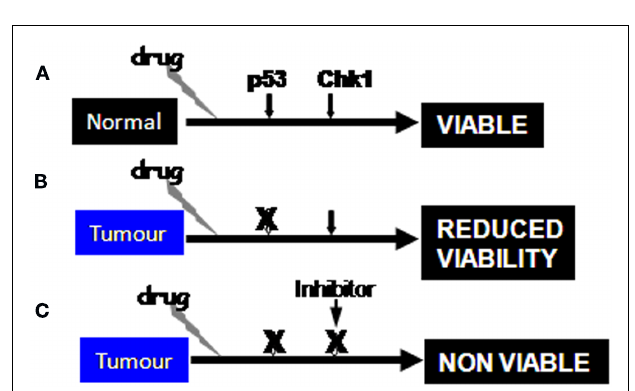
FIGURE 4 |Administration of genotoxic drugs can be readily responded to by p53-dependent mechanisms in normal tissues (A), whereas loss of p53 function will reduce cell viability and result in cells becoming reliant on the Chk1 dependent G2 phase checkpoint (B). Inhibition of Chk1 in combination with drug treatment results in loss of viability (C) .The same scenario operates with BRCA2 mutant cells where PARP inhibition blocks BER to produce synthetic lethality in response to endogenous DNA